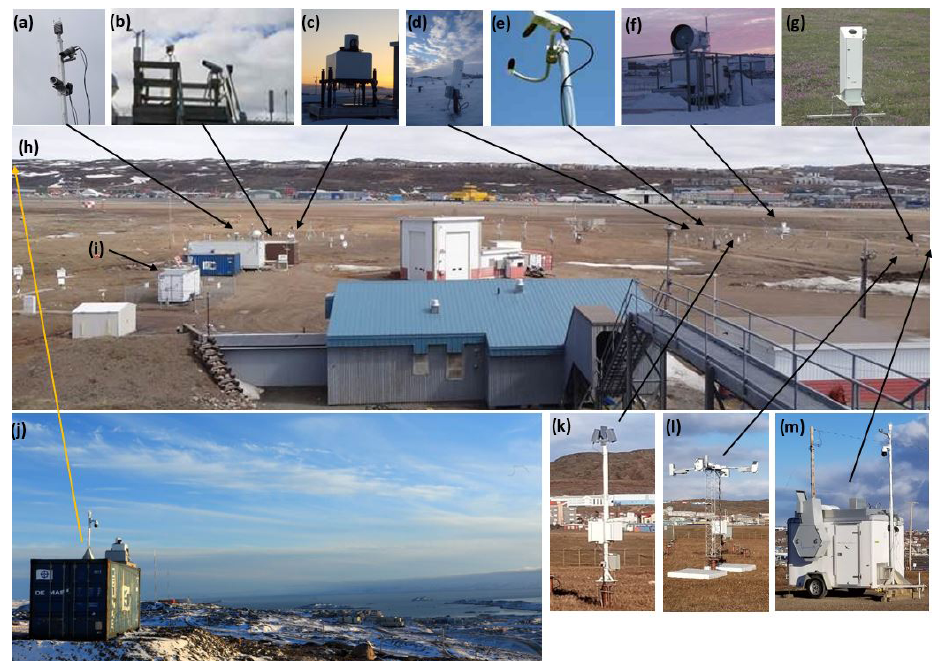
Figure 2. The Iqaluit supersite (h) as viewed in September 2017 from behind the main Weather Station Office (looking east from an elevated platform). The white MSC hydrogen building for radiosonde launches is located in the foreground alongside the standard WMO meteorological observation field. The Iqaluit airport (CYFB) is located in the distance, and Frobisher Bay is located to the right (off camera). Most of the CAWS instruments are shown in the insets: (a) WXT520 (top of the mast) with cameras (below), (b) PIP camera and backlight, (c) Doppler lidar, (d) ceilometer, (e) PWD52, (f) Ka-band radar, (g) DIAL, (h) supersite layout, (i) CAAAL trailer, (j) T121 site layout including a WXT520 and Doppler lidar, (k) POSS, (l) a radiation flux sensor suite with soil probes and snow depth sensors, and (m) FIRR (grey instrument) mounted on a trailer. Black arrows indicate each instrument’s approximate location; the yellow arrows in panels (h) and (j) indicate the approximate location of T121 atop the nearby ridge as seen from the Iqaluit supersite.